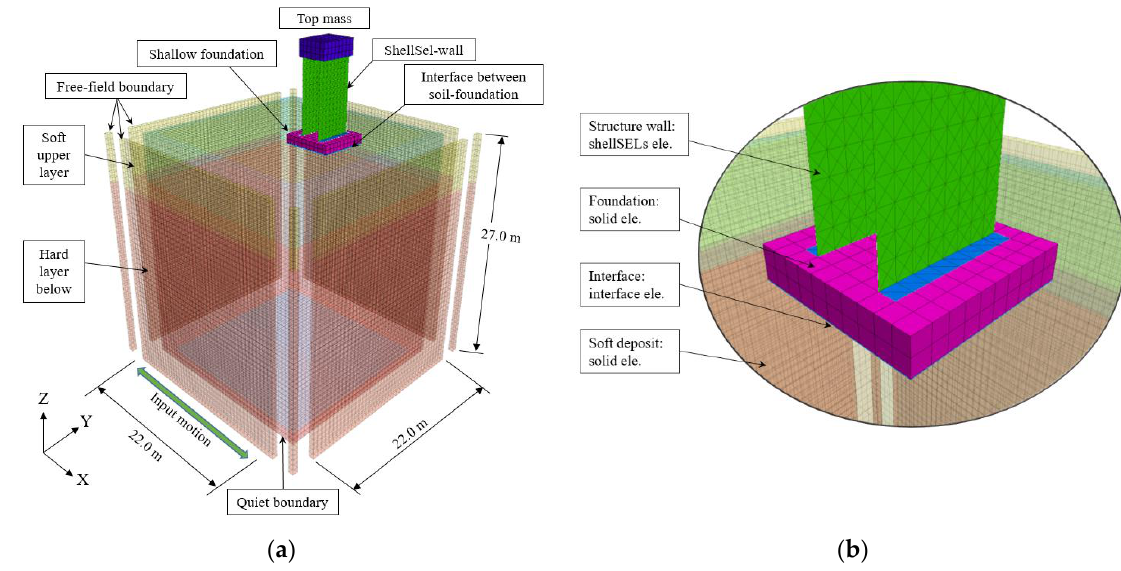
Figure 2. FLAC3D model with the S1 structure at ( a ) L2 profile case and ( b ) soil and structural elements. The foundation and top mass of structures were simulated using solid